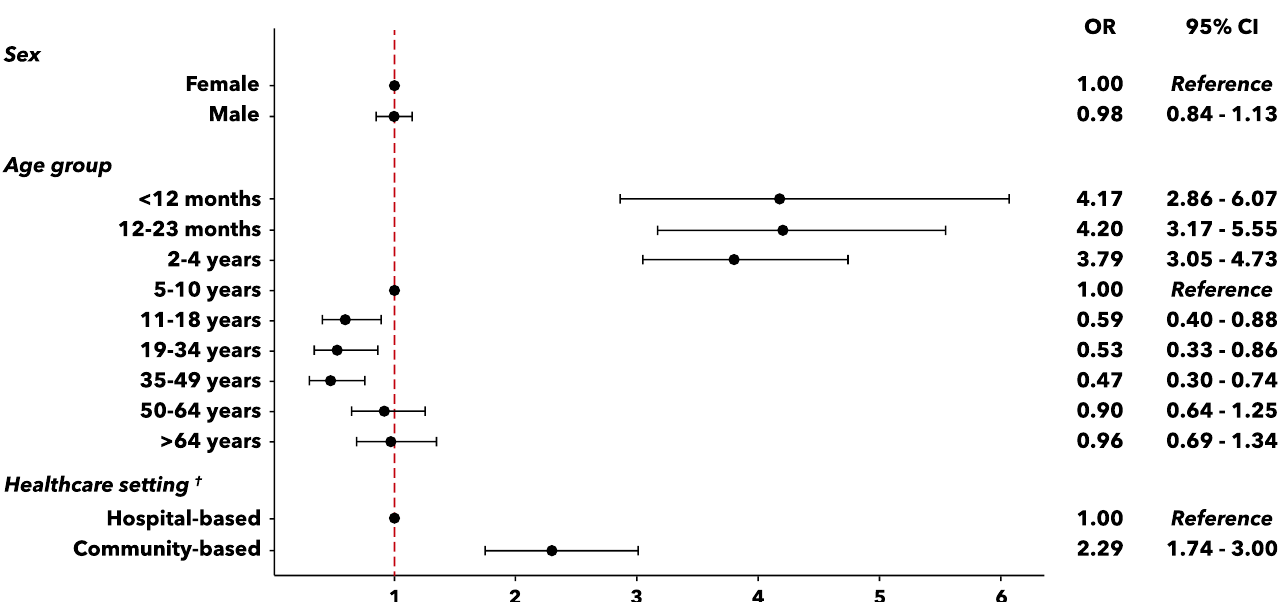
Figure 1. Forest plot for individual factors potentially associated to hRSV infection. OR = odds ratio, † Age-adjusted OR.